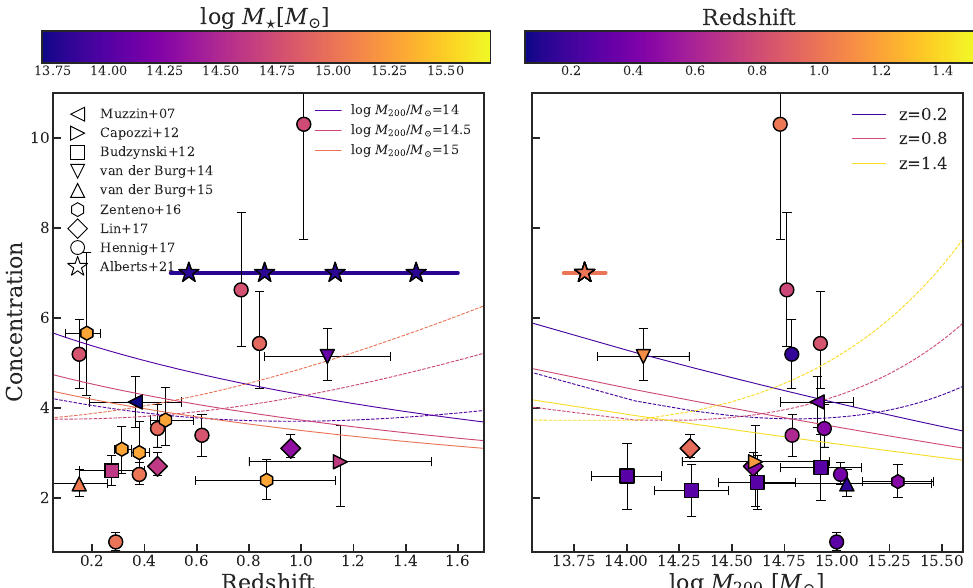
Figure 17. Halo concentrations ( c ≡ r 200 / r s ) derived from galaxy density profiles [805–811], stellar mass density profiles [384], and total light stacking [779] as a function of redshift ( left ) and M 200 ( right ). Solid and dashed lines show the DM halo concentrations from [799,812], respectively. DM concentrations are relatively flat with redshift and halo mass, with the exception of an upturn at high-mass predicted for unrelaxed clusters. The stellar component is often observed to be less concentrated than the DM, but with exceptions at high redshift and low-mass, which may reflect complex baryonic physics in unrelaxed or merging systems.